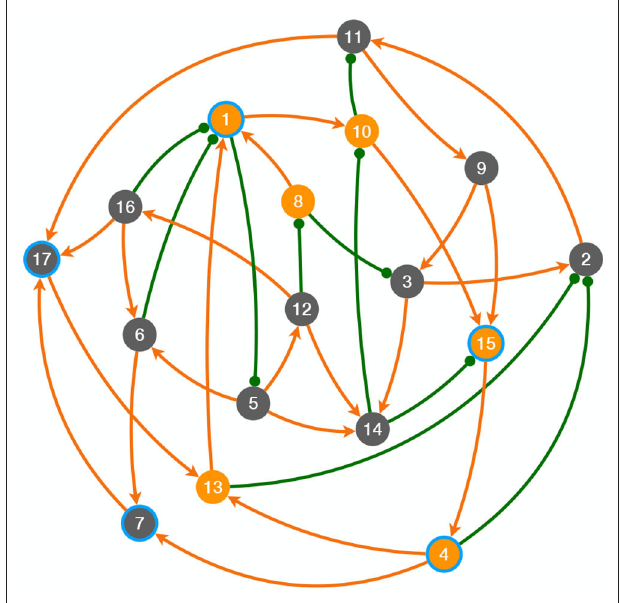
FIGURE 1 | Sidigraph displaying the model system. The descriptions of variables are shown in Table 1 . Gray/orange nodes represent system variables with positive/negative normative values. Nodes surrounded by cyan rings indicate variables that are not targets for direct intervention. Orange links ended in arrowheads represent positive influences. Green links ended in circles represent negative